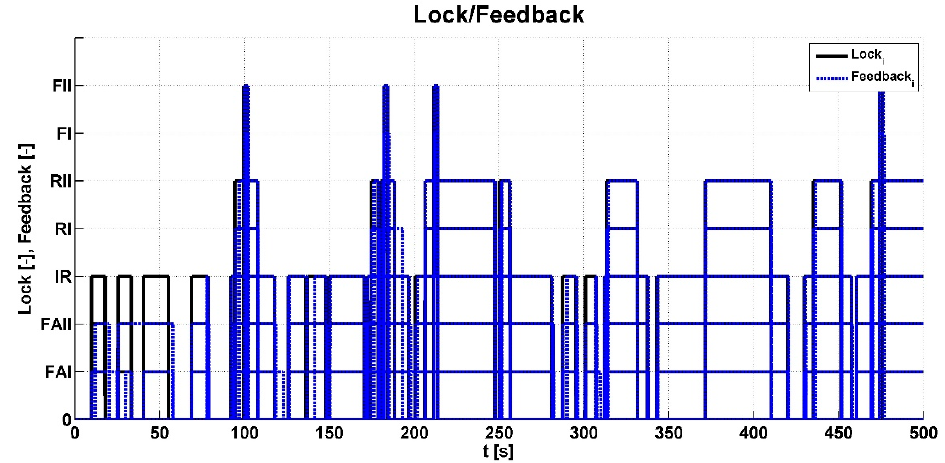
Figure 14. Status of locking/unlocking and feedback.